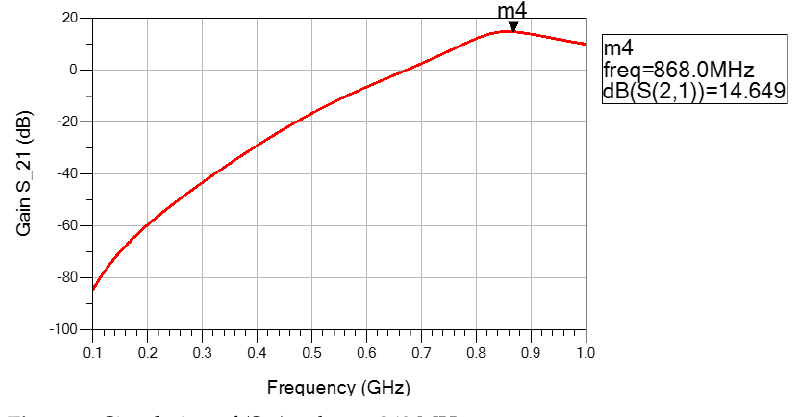
Figure 8. Simulation of (S 21 ) value at 868 MHz. Table 3. Variation of gain and current consumption under tuned supply